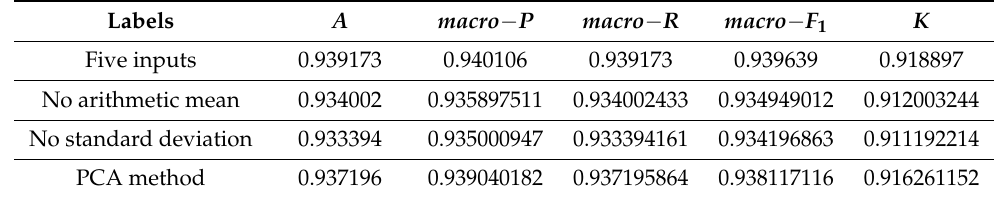
Table 9. Statistical table of numerical indicators of input dimension